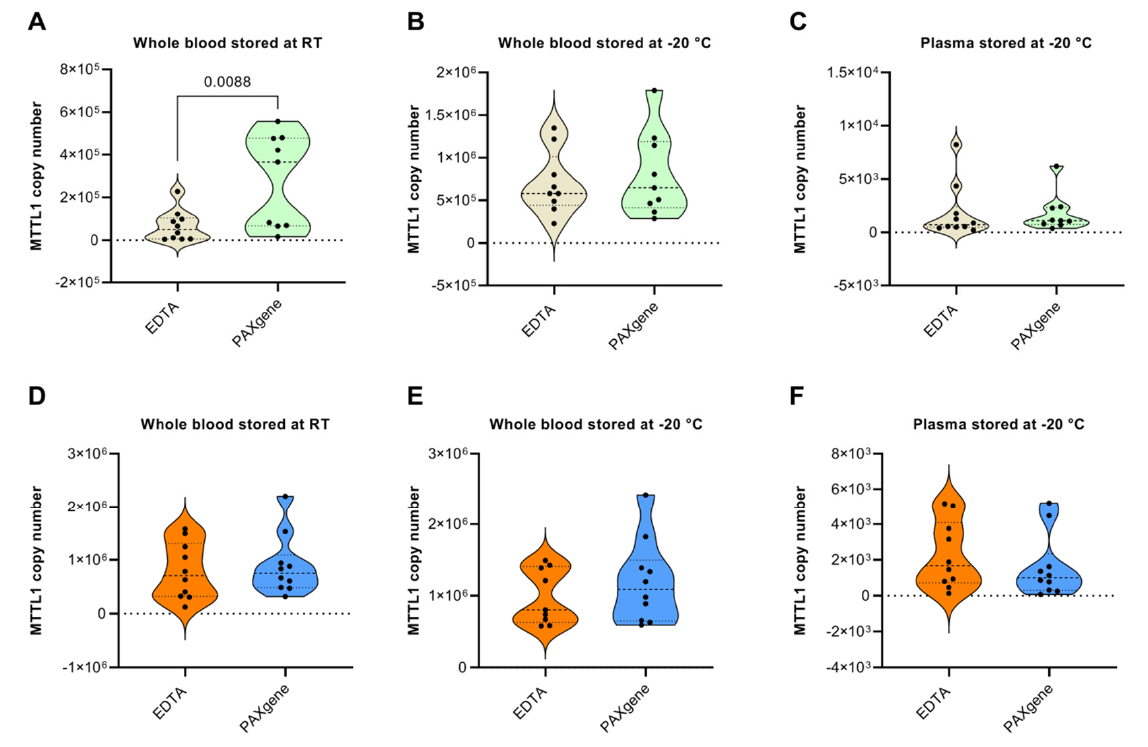
Figure 3. EDTA vs. PAXgene tubes for the storage of mitochondrial DNA (mtDNA). MtDNA copy number in whole blood of healthy subjects stored in EDTA vs. PAXgene tubes at ( A ) RT for 3 h prior to processing and ( B ) − 20 ◦ C prior to processing. ( C ) Comparison of mtDNA copy number in plasma samples of healthy subjects stored in EDTA vs. PAXgene tubes at − 20 ◦ C prior to processing. MtDNA copy number in whole blood of pancreatic cancer patients stored in EDTA vs. PAXgene tubes at ( D ) RT for 3 h prior to processing and ( E ) − 20 ◦ C prior to processing. ( F ) Comparison of mtDNA copy number in plasma samples of healthy subjects stored in EDTA vs. PAXgene tubes